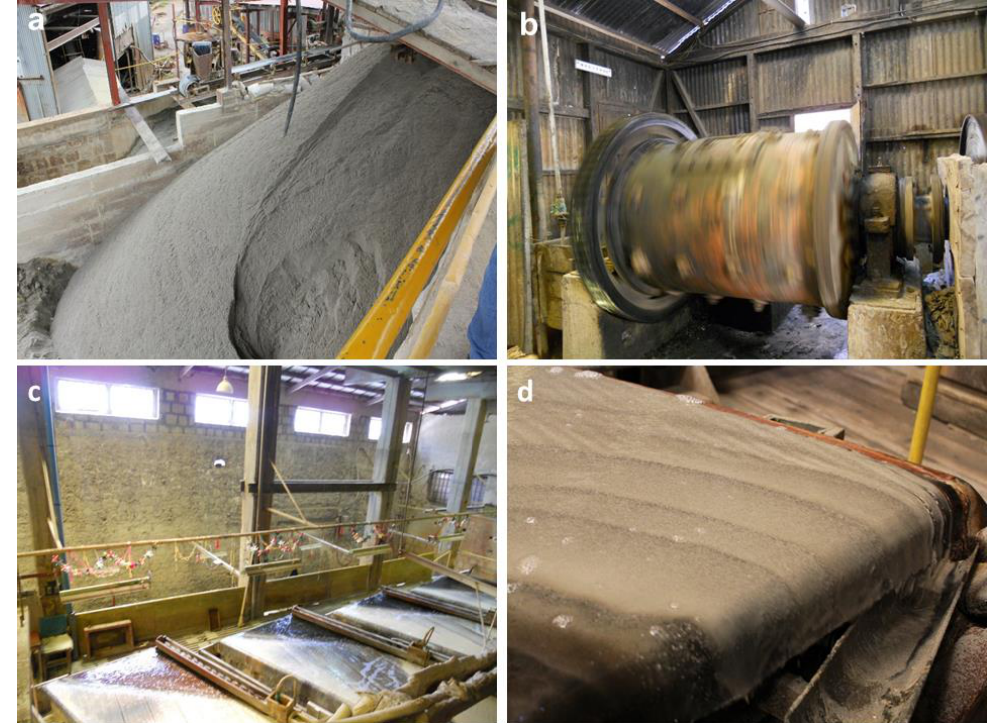
Figure 3. View of the Catavi processing plant: ( a ) feed tailings; ( b ) ball mill for the comminution; ( c ), view of one of the three floors with the material being processed in the shaking tables; ( d ), detail of the gravity separation in a shaking table.